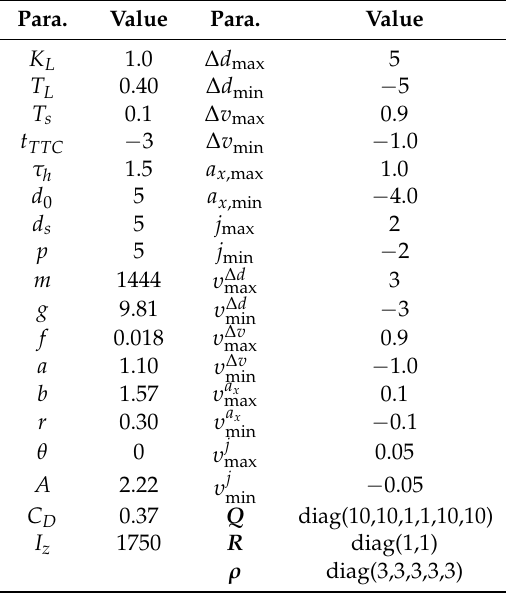
Table 1. Parameters of the IACC Controller. IACC: integrated adaptive cruise control. Para. Value Para. Value K L 1.0 ∆ d max 5 T L 0.40 ∆ d min − 5 T s 0.1 ∆ v max 0.9 t TTC − 3 ∆ v min −